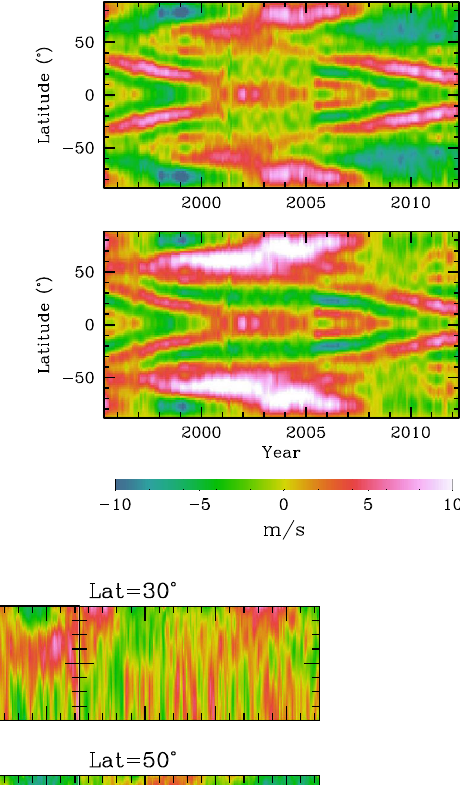
Fig. 33 The zonal flow velocity at 0 . 98 R (cid:6) as determined using GONG data plotted as a function of latitude and time. The top panel was obtained by subtracting the average of the cycle 23 rotation velocities, while the lower panel is that obtained by subtracting the cycle 24 average rotation between 2009 and 2012. (Figure from Antia and Basu 2013)